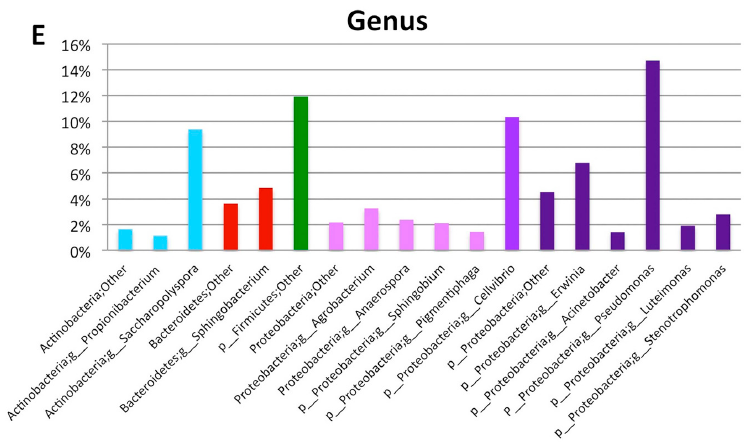
Figure 2. Bone microbiome composition. ( A – E ) 16S rRNA sequencing of the bone tissue microbiome. Bacterial composition (frequency > 1%) is shown from phylum to genus level. ( A ) Proteobacteria was the most abundant phylum with a frequency of 59%; within this phylum, we found the prevalence of Gammaproteobacteria (45% of frequency, class level, panel B ); Pseudomonadales (16% of frequency, order level, panel C ); Pseudomonadaceae (15% of frequency, family level, panel D ); and Pseudomonas (15% of frequency, genus level, panel E ). A complete list of the bacteria that reached the deepest taxonomic assignment (i.e., genus) using a filter of 0.05% of OTU frequency is shown in Table 1 and Supplementary Figure S2.